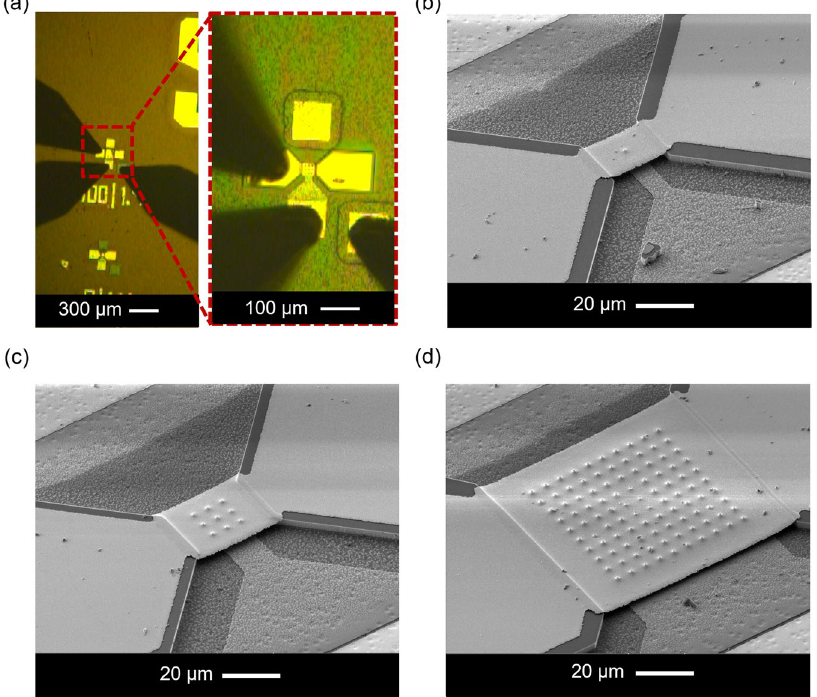
Figure 3. ( a ) Optical micrograph of a GaN FET device under test using a source meter unit (SMU) and probing tips. SEM images of vertical n-p-n GaN NW FETs consisting of ( b ) 1, ( c ) 9, and ( d ) 100